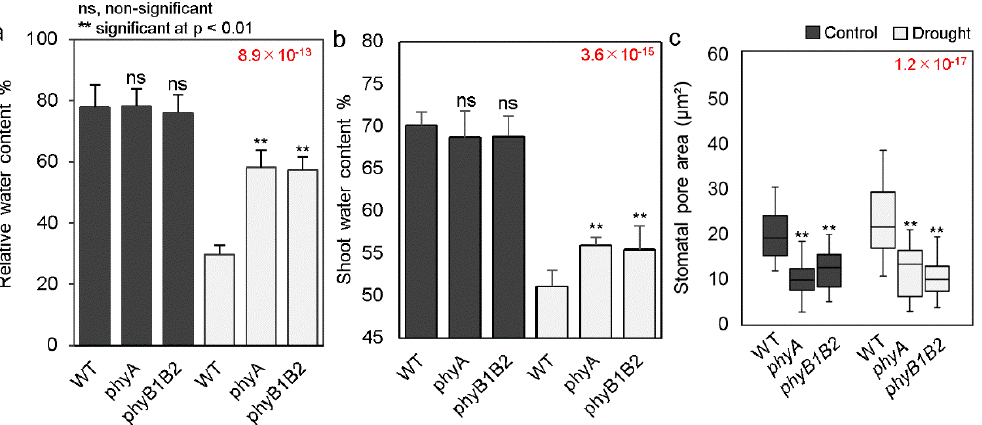
Figure 3. Plant water status of WT, phyA , and phyB1B2 under drought stress. Leaf relative water content (leaf RWC) % ( a ), shoot water content ( b ), and stomatal pore area ( c ) of one-month-old plants after water withholding for 8 days (d) in comparison with fully watered conditions. Data represent the average ( n ≥ 4) ± SD (standard deviation) from a representative of three biological individualistic experiments. The significant variants of statistical analysis are identified by two asterisks for p < 0.01, whereas ns indicates individually statistically non-marked differences between the studied genotypes under non-stress and stress conditions in accordance with a post hoc Tukey HSD test with ANOVA. The ANOVA p-values are shown in red. Additionally, the p -values of the post hoc test are presented in Supplementary Materials (Table S2).